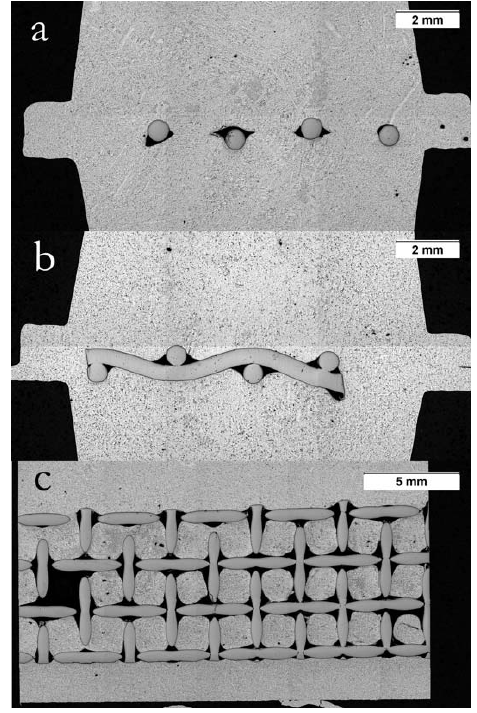
Figure 2: Transversal (a,b) and longitudinal (c) sections used for the metallurgical